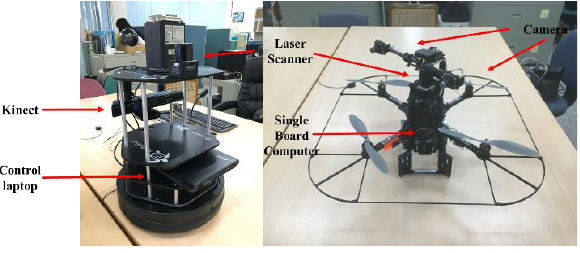
Figure 6. The configuration of mapping sensors on robot